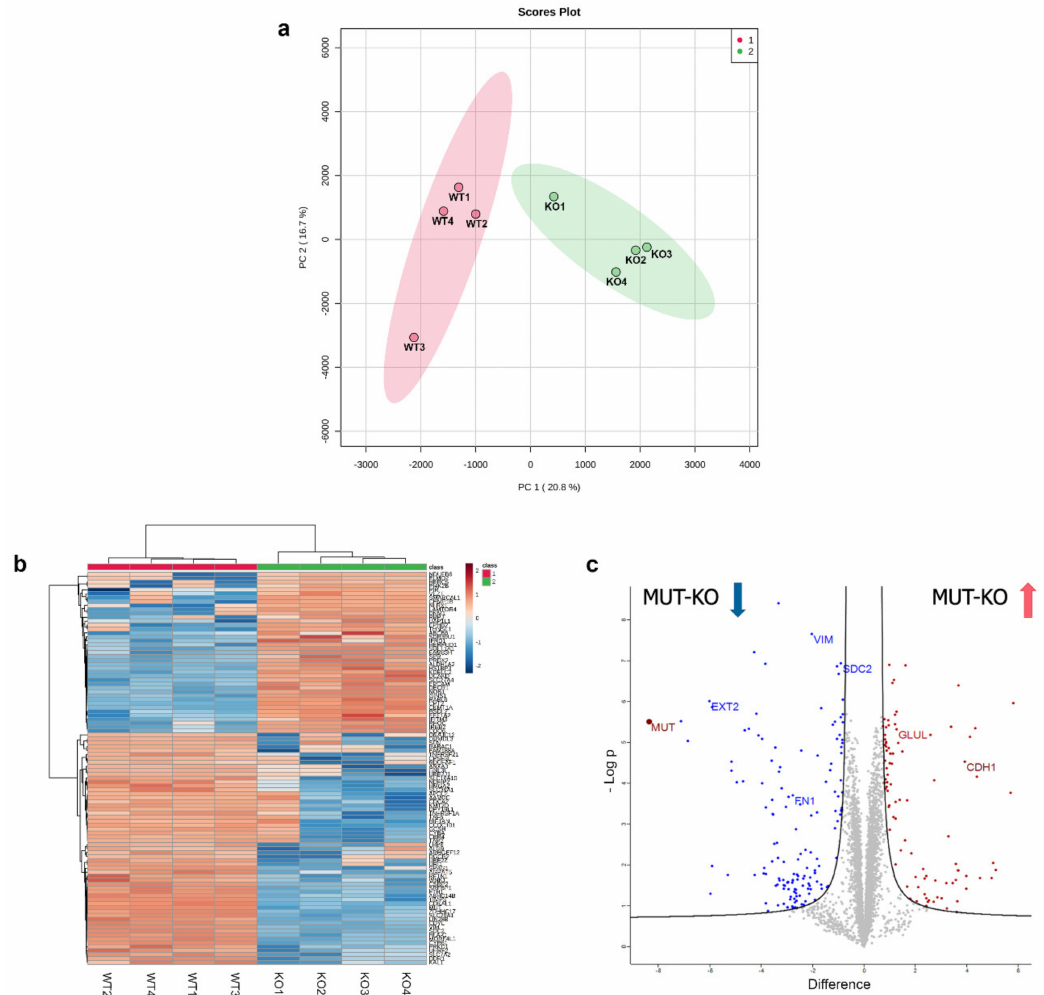
Figure 3. Graphic representation of the label-free proteomic experiment. Protein intensities calculated by label-free quantification (LFQ) were imported into the MetaboAnalyst 4.0 tool for the generation of the ( a ) principal component analysis (PCA) plot and ( b ) heatmap. x - and y -axis of the PCA plot report PC 1 and PC 2 that define 20.8% and 16.7% of the total variance, respectively. ( c ) The volcano plot for the visualization of the global proteome distribution in MUT-KO was obtained by plotting the log2 protein di ff erence between MUT-KO and WT on the x -axis against the statistical significance, reported on the y -axis as -Log p. Blue and red dots represent the statistically significant down- and upregulated proteins, respectively. MUT can be visualized in the left part of the graph, indicated by a dark-red dot. The volcano plot shows by their name some significant proteins that were discussed along the manuscript (VIM: Vimentin; EXT2: Exostosin-2; SDC2: Syndecan-2; FN1: Fibronectin; GLUL: Glutamine synthetase; CDH1: